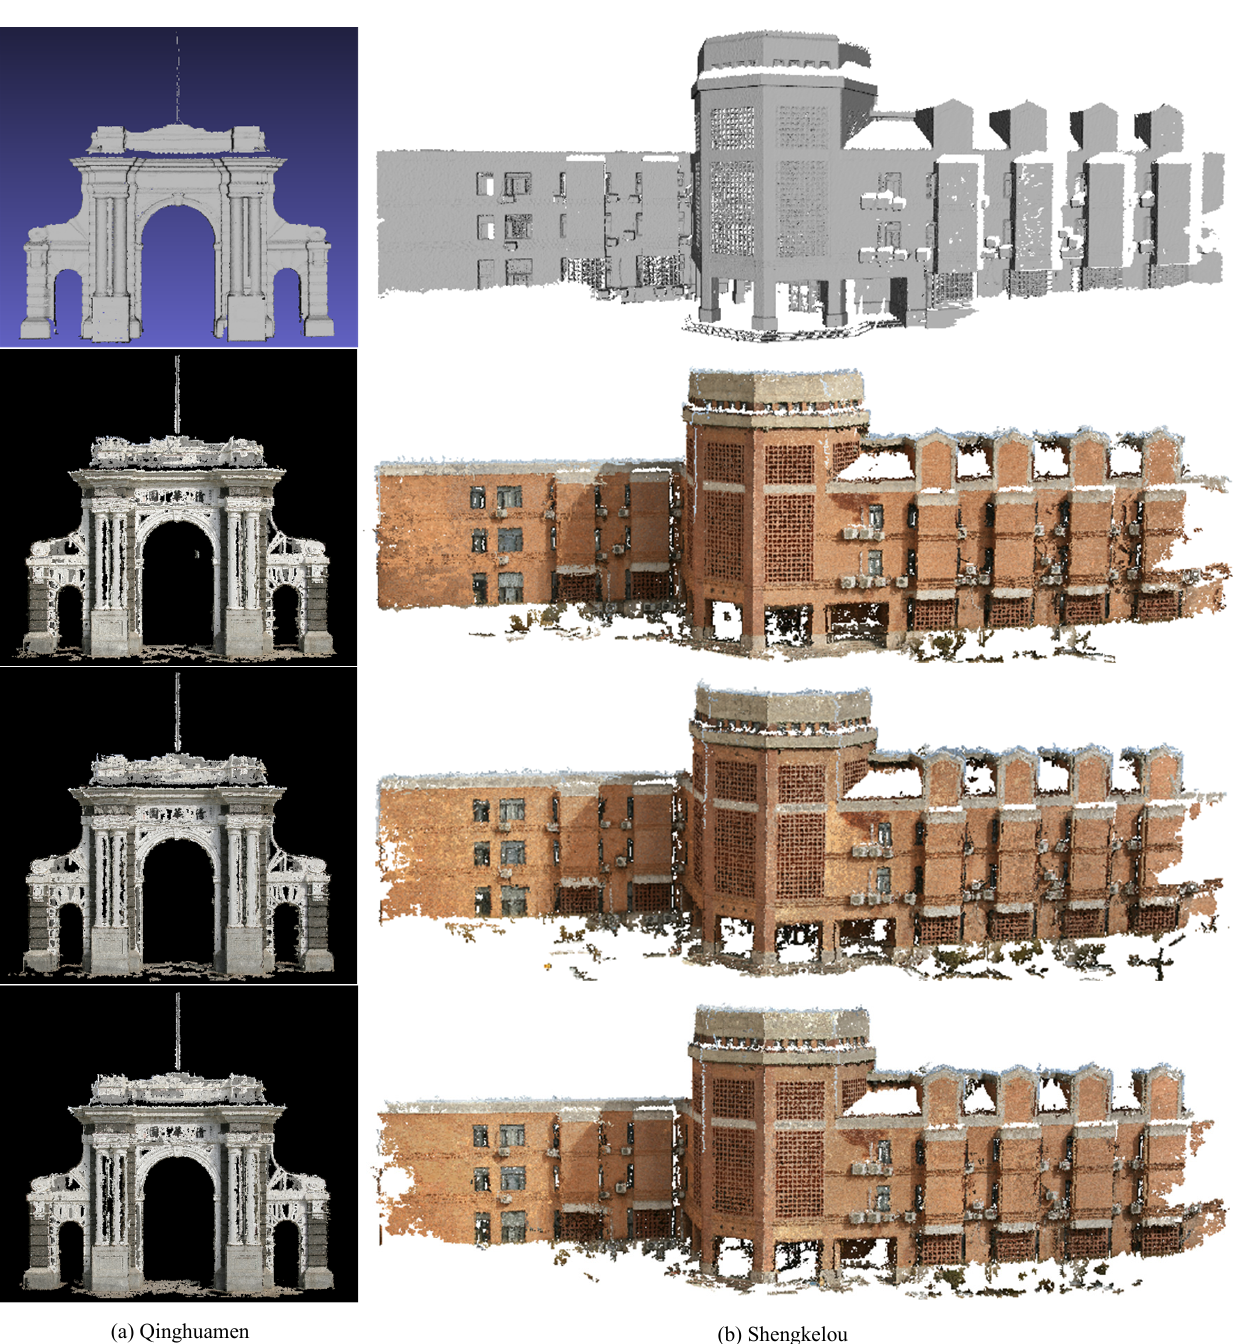
Figure 10. Comparison of recovered point cloud models by the three reconstruction methods when τ = 50%. ( a ) “Qinghua- men”(68 images, 4368 × 2912), ( b ) “Shengkelou”(102 images, 4368 × 2912). Top to bottom: ground-truth, ours, PMVS, VisualSfM. In the pillar area of “Qinghuamen” and the left part of the facade of “Shengkelou”, ours generates more points than PMVS and